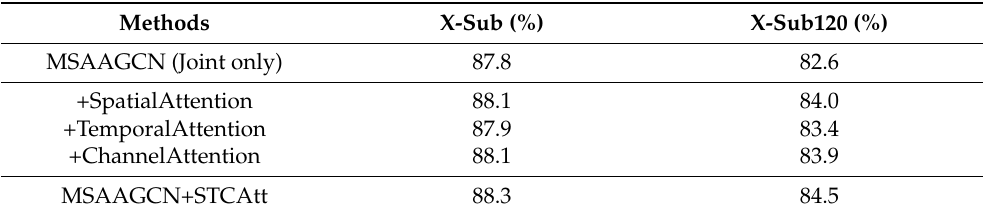
Table 3. Comparisons of the recognition accuracy with different attentions on the X-sub and X-sub120